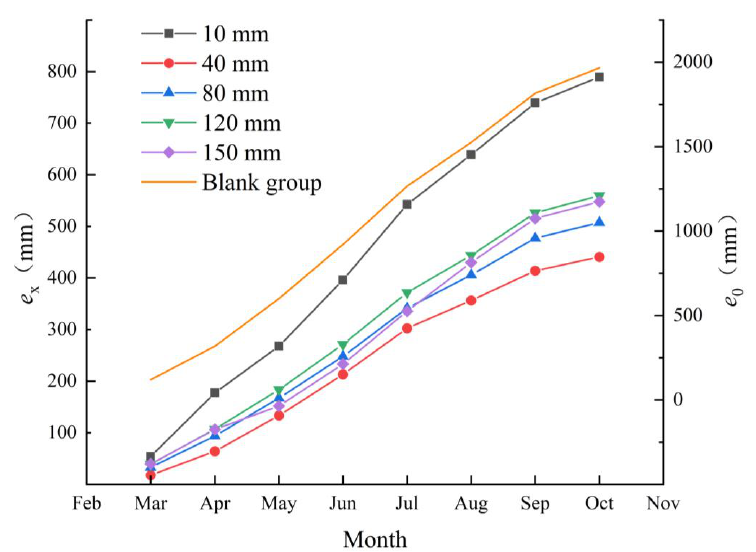
Figure 7. Cumulative evaporation capacities of all evaporators for different diameter